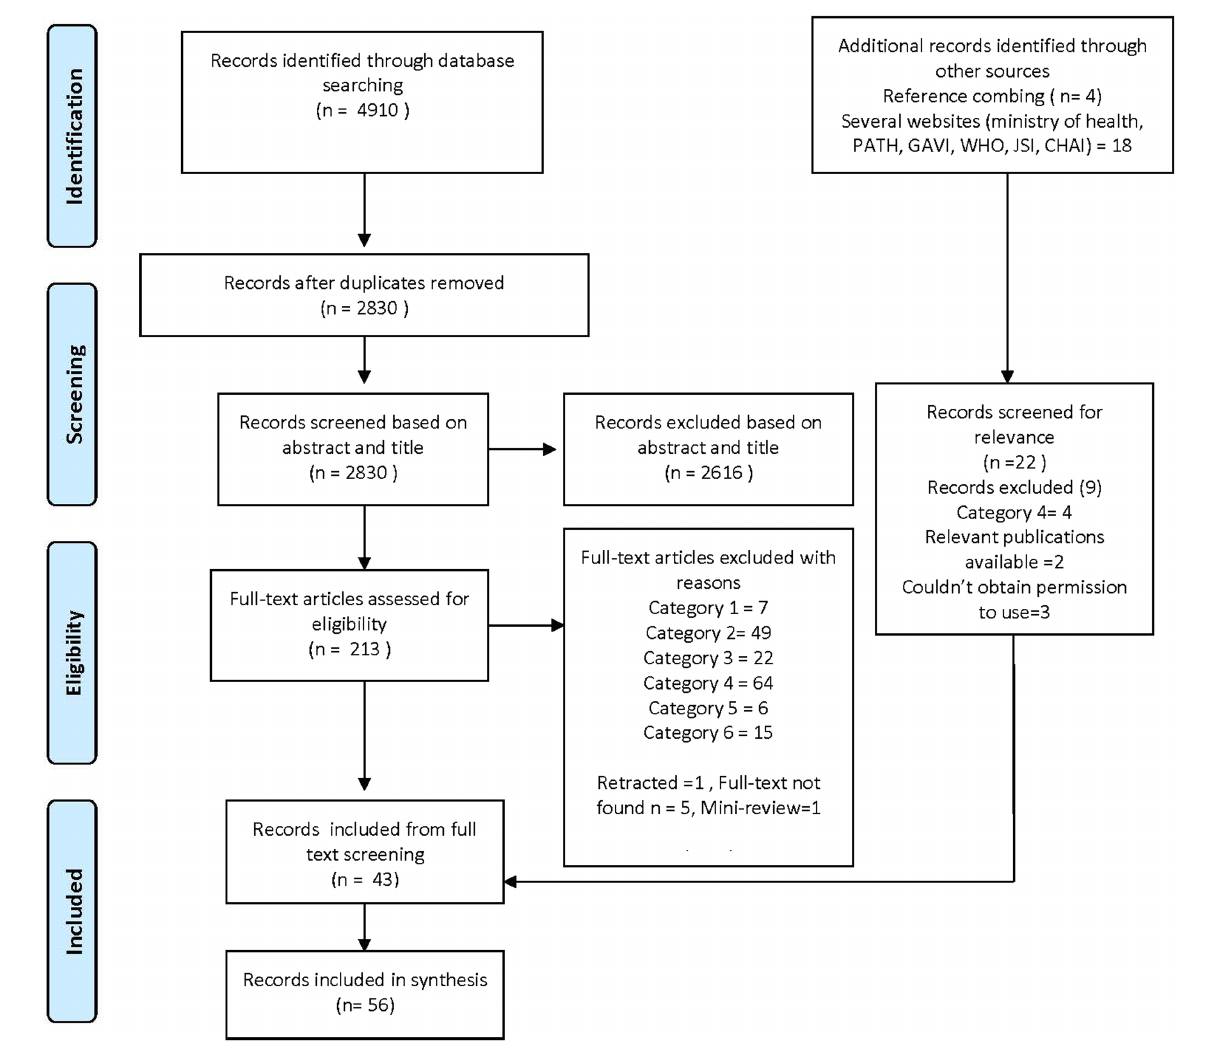
FIGURE 1 Systematic literature review flow. Publications in the second round were excluded if (1) from HICs and failed to be excluded in the first round, (2) from Upper middle-income countries (UMICs), (3) covered personal beliefs, knowledge, acceptability, uptake, vaccine hesitancy and attitudes among parents, women and adolescents, (4) not focused on the national HPV vaccination program, (5) hypothetical acceptance studies or studies discussing disease burden before vaccine introduction, and (6) detailed modeling studies on cost-effectiveness analysis or cost estimation of HPV vaccination